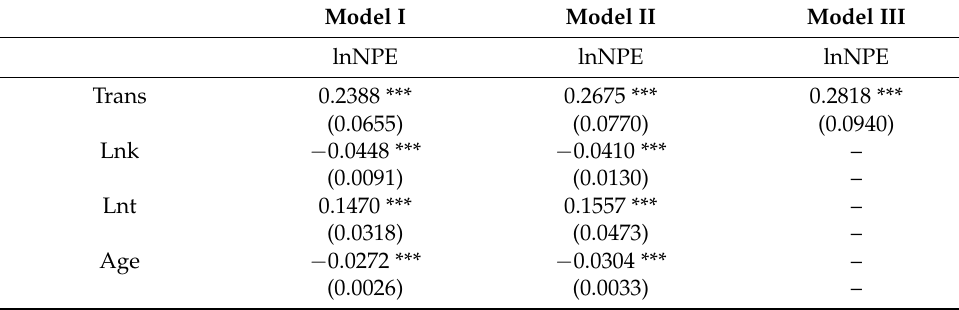
Table 12. Estimation Results of the Average Effect of Robust